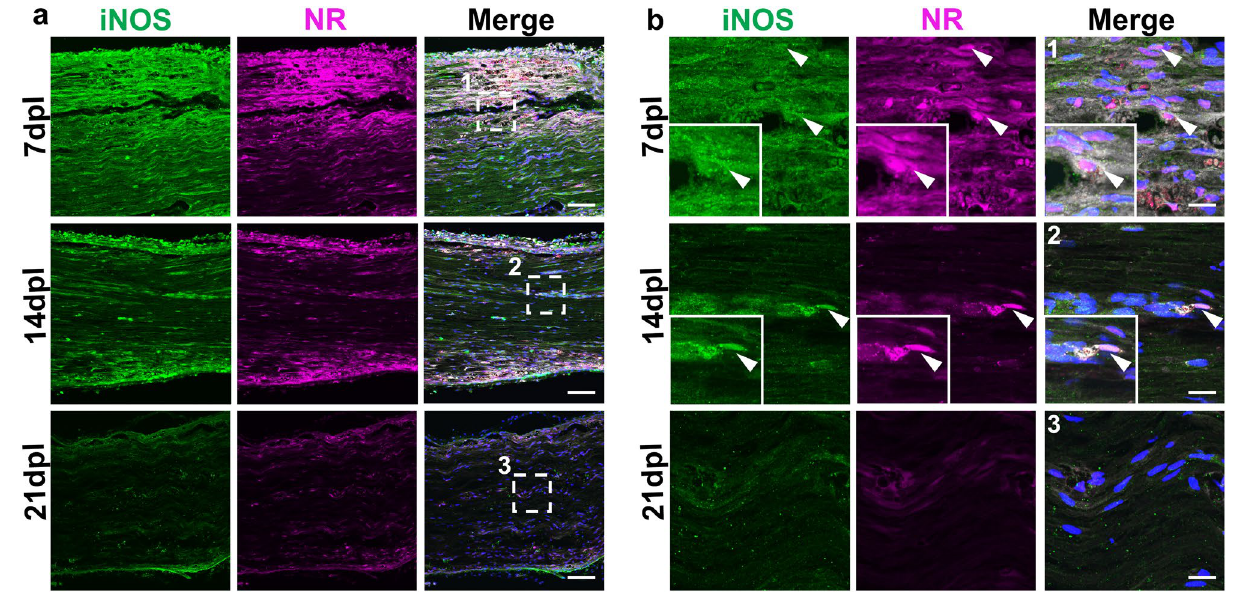
Figure 6. Neutral red (NR) colocalized with M1 type macrophages. Representative confocal images of NR (magenta) and immunofluorescence staining for iNOS (green) at low ( a ) and high ( b ) magnification in areas with lysophosphatidylcholine injection at 7, 14 and 21 dpl (n = 3 mice per timepoint examined). ( b1–3 ) Enlarged images of ( a1–3 ) (white dotted square). iNOS-positive cells colocalized with NR at 7 dpl ( b , arrowhead). iNOS positive cells with NR signals are also present at 14 dpl. Insets Enlargements of double-positive cell. Nuclei were counterstained with Hoechst (blue). Scale bar, 50 µm ( a ) and 20 µm ( b ).